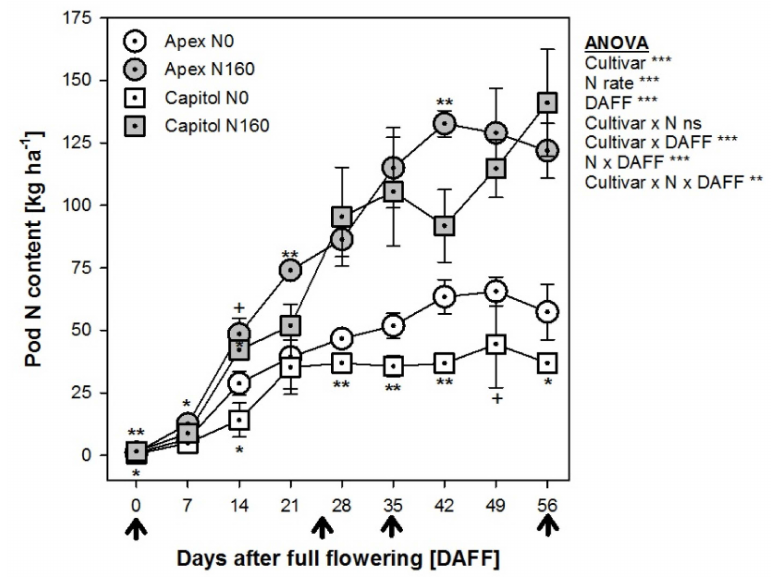
Figure 5. Nitrogen accumulation in the pods from full flowering until maturity of the winter oilseed-rape line-cultivars Apex and Capitol as affected by N fertilization rate (N0 and N160). The arrows indicate the developmental stages BBCH65, BBCH69, BBCH79, and BBCH89, respectively. ANOVA: ** and *** indicate significant differences at p < 0.01 and p < 0.001, respectively. ns = non-significant. Individual DAFF: +, *, and ** indicate significant differences between the cultivars within the N fertilization rates at p < 0.10, p < 0.05, and p < 0.01, respectively. The error bars (visible only when greater than the symbols) represent the standard deviations of the means ( n =